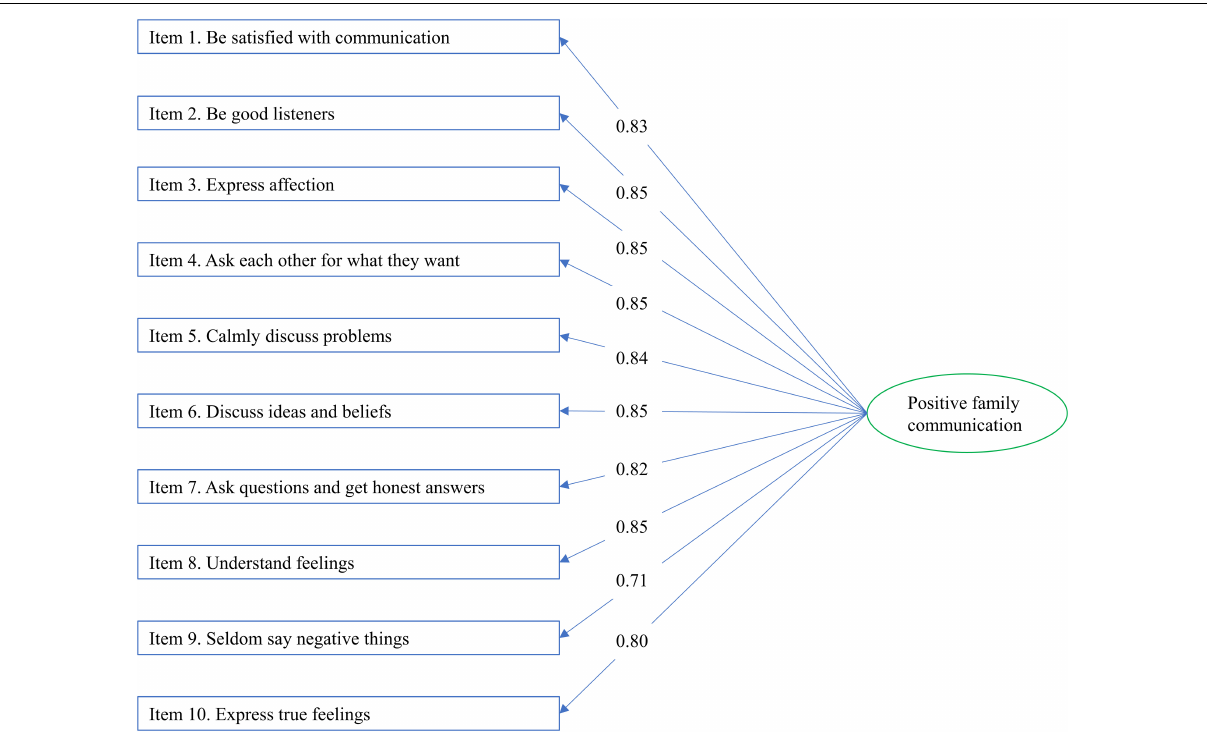
in the population-based sample ( Table 6 ). Frequent